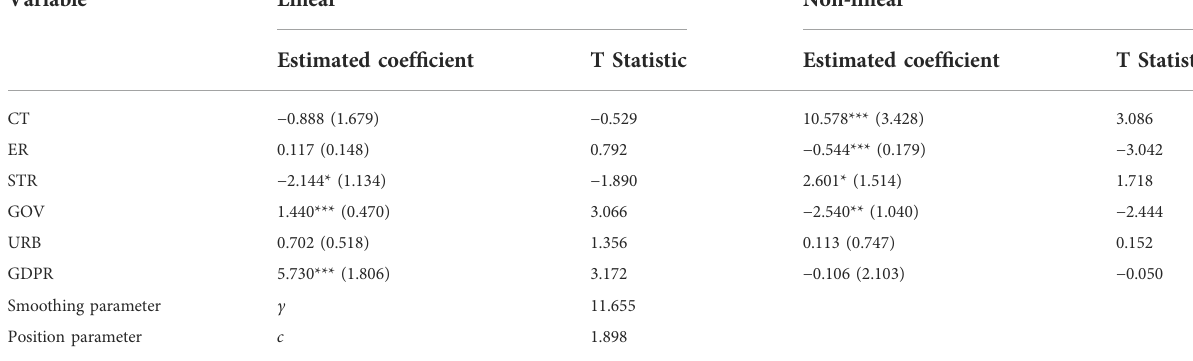
TABLE 6 Estimation results of lagged PSTR model.